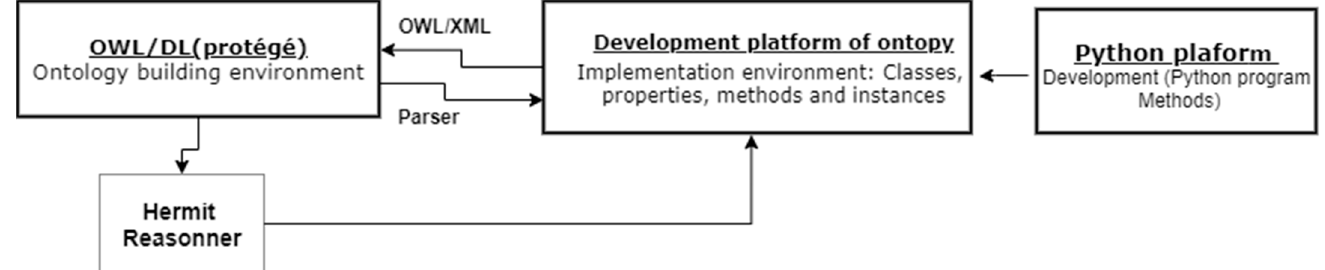
Figure 15. Ontopy’s development platform architecture.